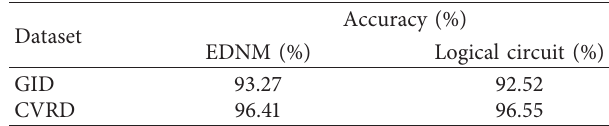
Table 10: Accuracy comparison of EDNM and logical circuits.